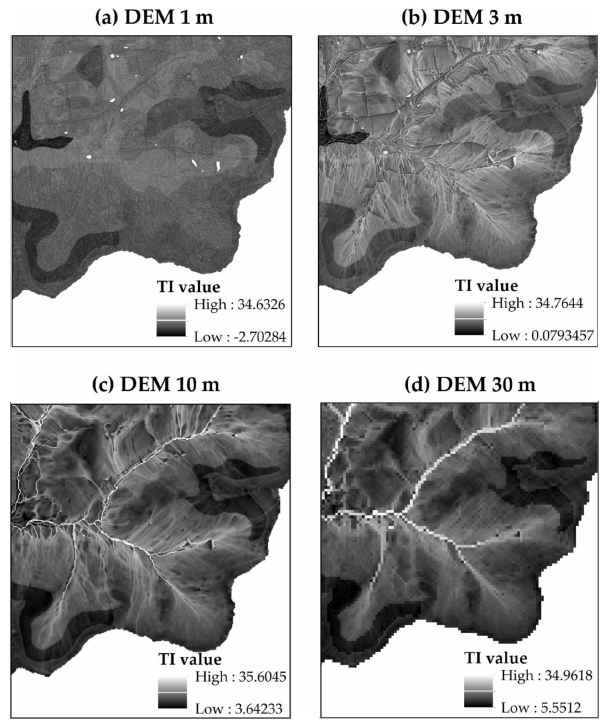
Figure 13. Distribution of topographic index values using different